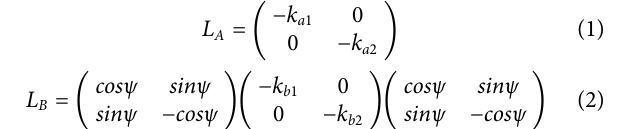
Frontiers in Robotics and AI |